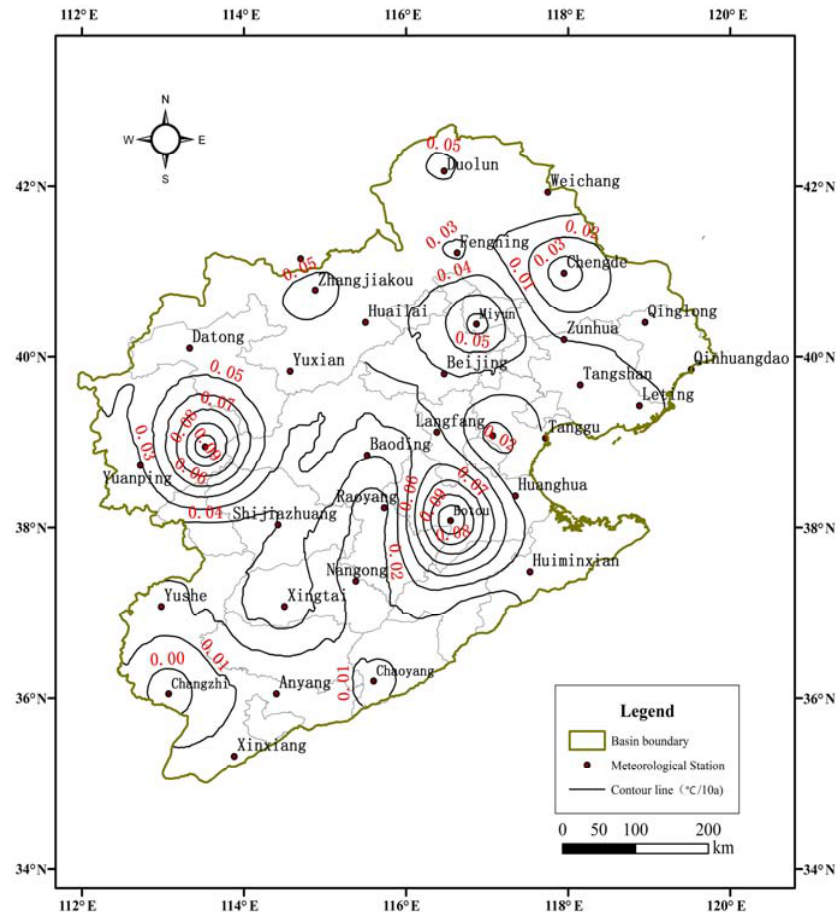
Figure 4. Contour map of average temperature gradient in the Haihe River Basin.